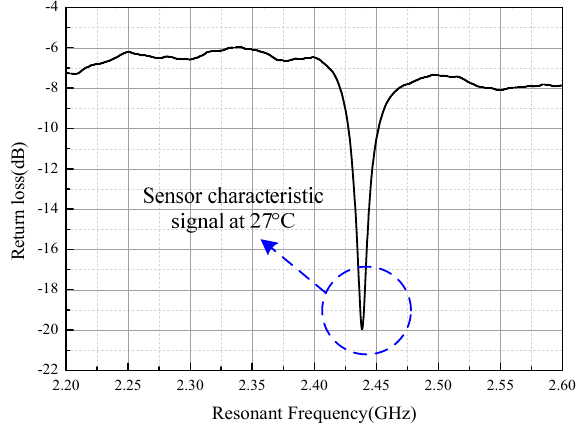
Figure 8. Detected original sensor response curve.